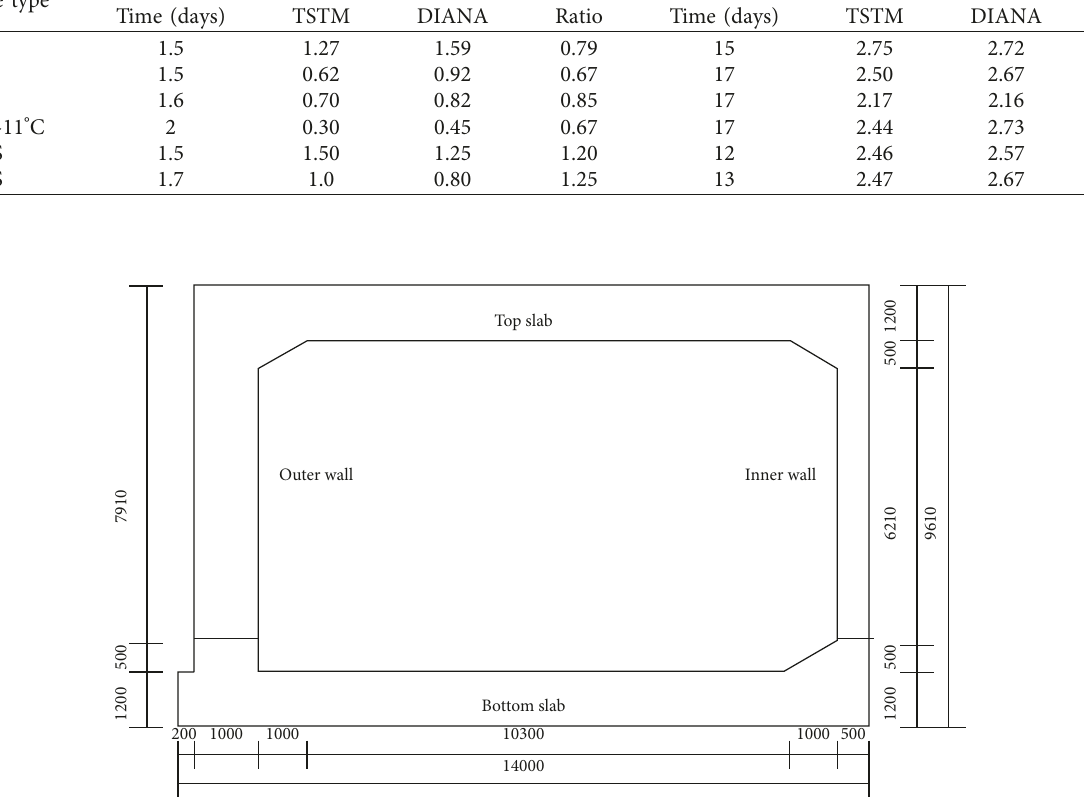
Figure 4: Geometry of the submerged tunnel (half of the cross section treated as symmetric).